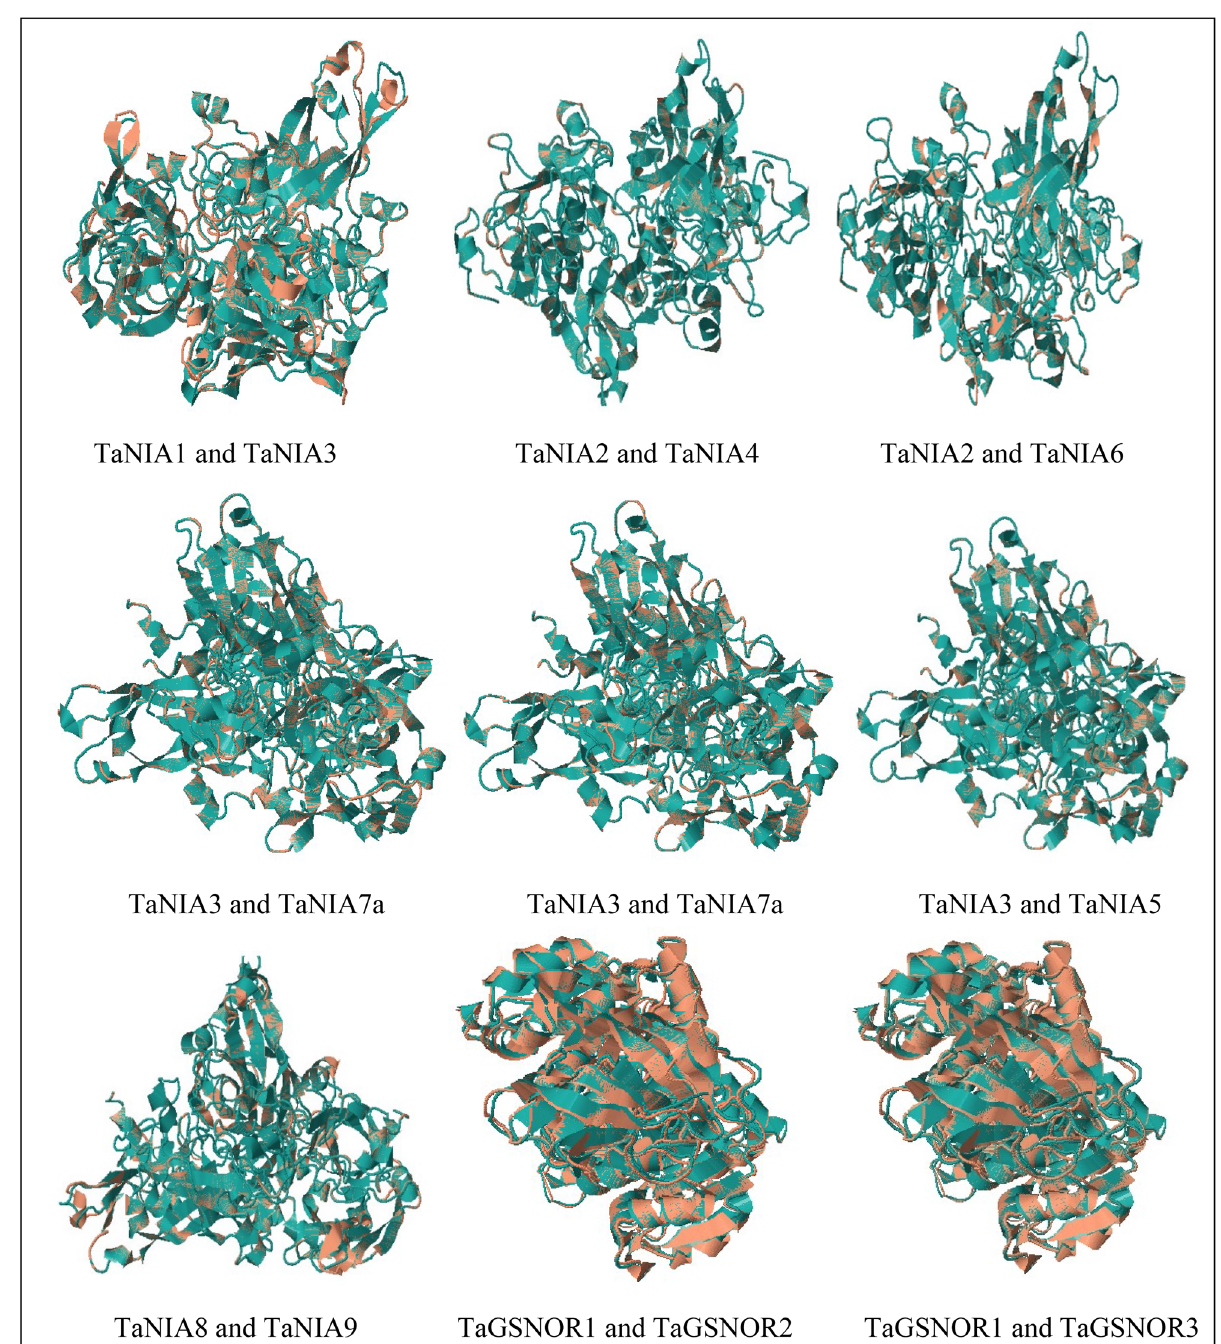
Figure 5. Structural overlapping of TaNIA and TaGSNOR proteins predicted using CLICK server (http:// cospi. iiser pune. ac. in/ click/). The alignment of pair of proteins in CLICK identify structural similarity by superimposing the 3D structures, independent of their topology. Images were created in CLICK server (http:// cospi. iiser pune. ac. in/